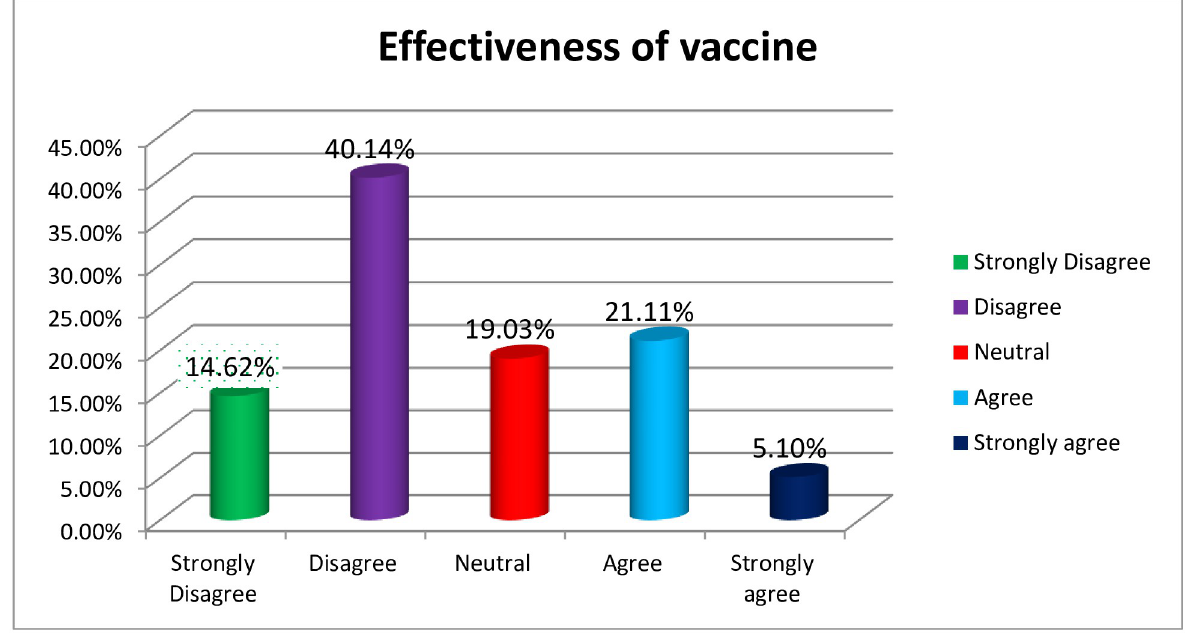
Fig 1. Attitude of the health professionals regarding effectiveness of the Corona virus vaccine,